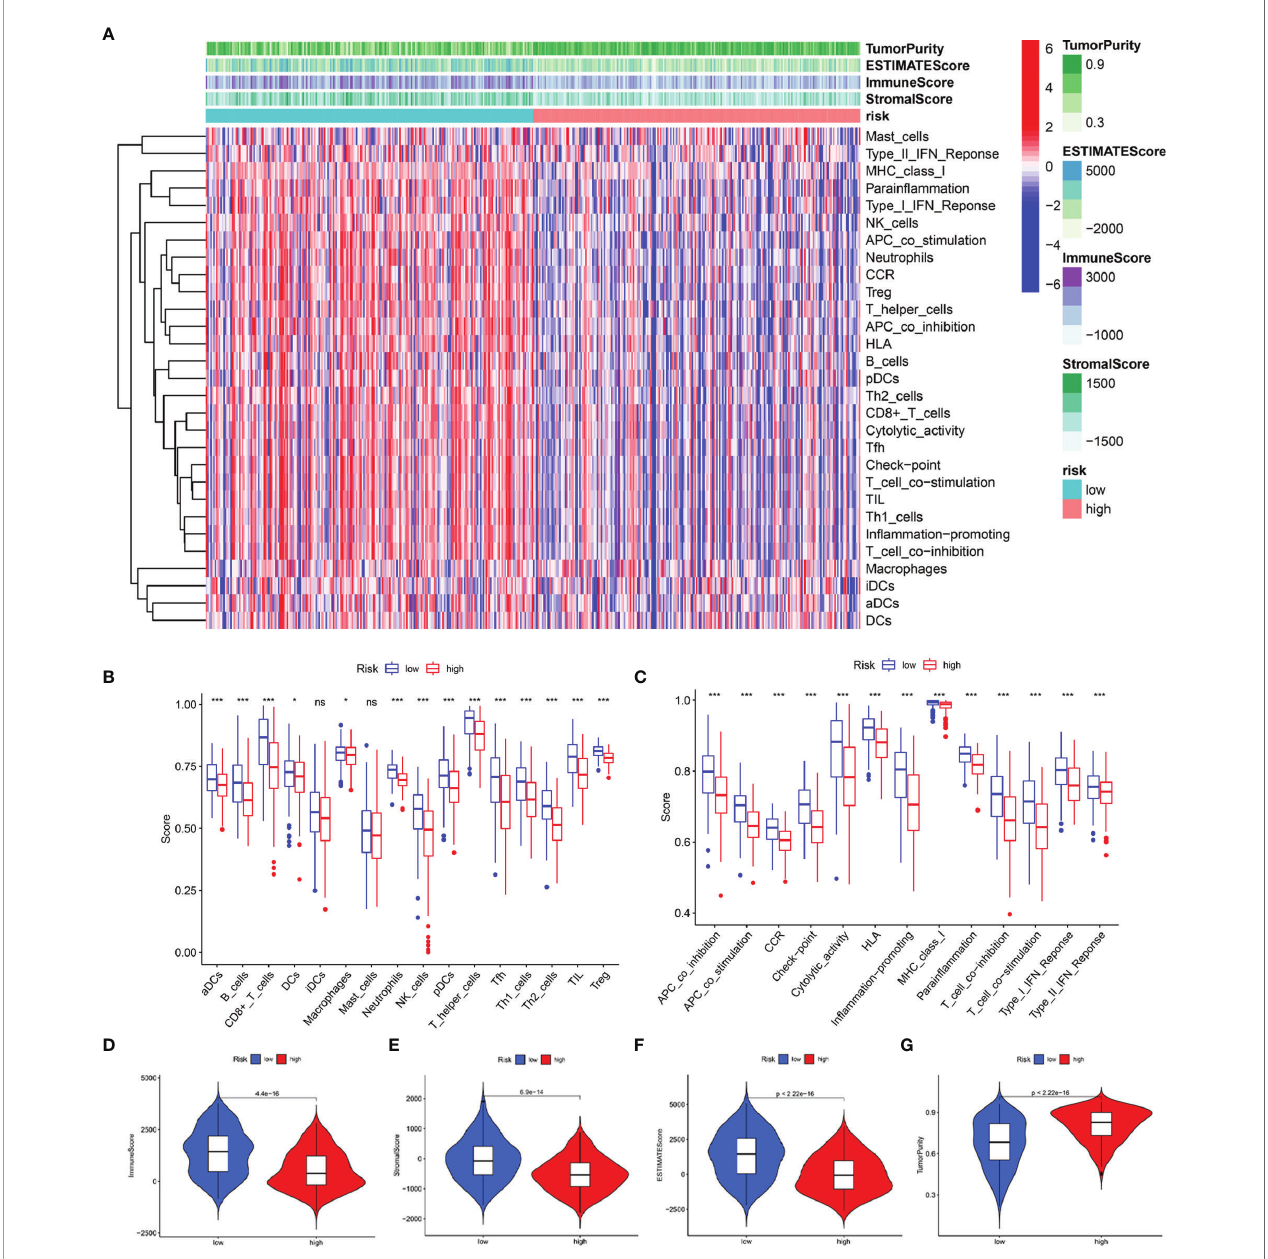
FIGURE 10 | Predicted evaluation of immune microenvironment characteristics. (A) Heatmap indicates the scores for tumor purity and the tumor microenvironment between the low- and high-risk groups. (B) The differences in the proportions of 16 immune cells between the low- and high-risk groups. (C) The differences in the proportions of 13 immune-related pathways between the low- and high-risk groups. The distributions of the immune score (D) , stromal score (E) , ESTIMATE score (F) , and tumor purity (G) between the low-and high-risk groups *P < 0.05; ***P < 0.001; ns, no signi fi